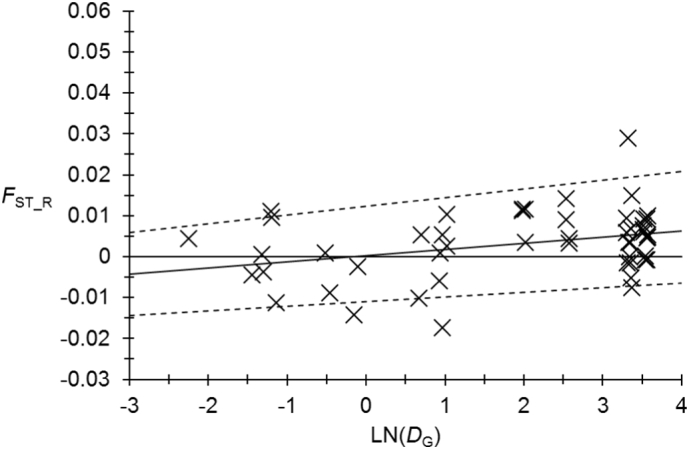
Isolation by distance for contemporaneous subsamples of Glossina palpalis palpalis from Bonon and Sinfra in Ivory Coast before treatment (T0). The average regression line is represented as a straight line and the 95% confidence intervals (95%CI), obtained after 5000 bootstraps over loci, are in dotted lines. Abscisses are the natural logarithms of geographic distances in km. Ordinates are Rousset's FST_R corrected for null alleles by FreeNA. Average slope was 0.0015 in 95%CI = [0.0011…0.0021]. Mantel test p-values were 0.4158 and 0.00795 for DCSE and FST_R respectively.